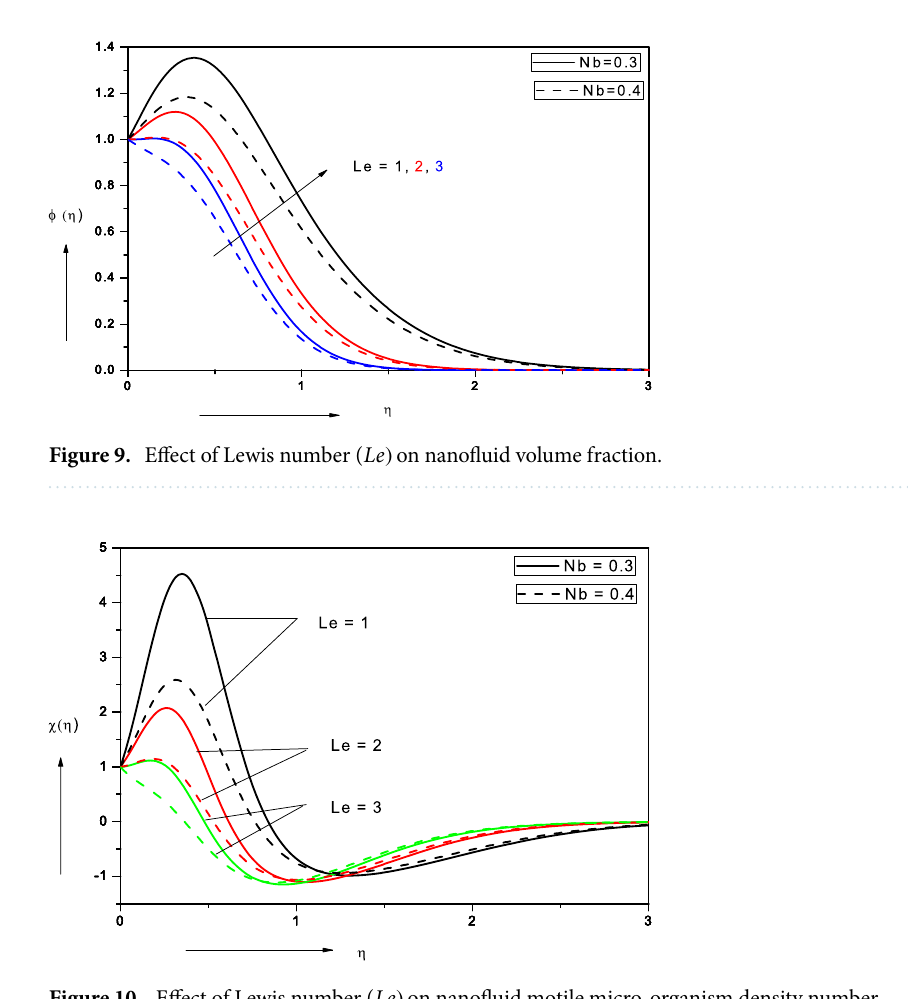
Figure 10. Effect of Lewis number ( Le ) on nanofluid motile micro-organism density